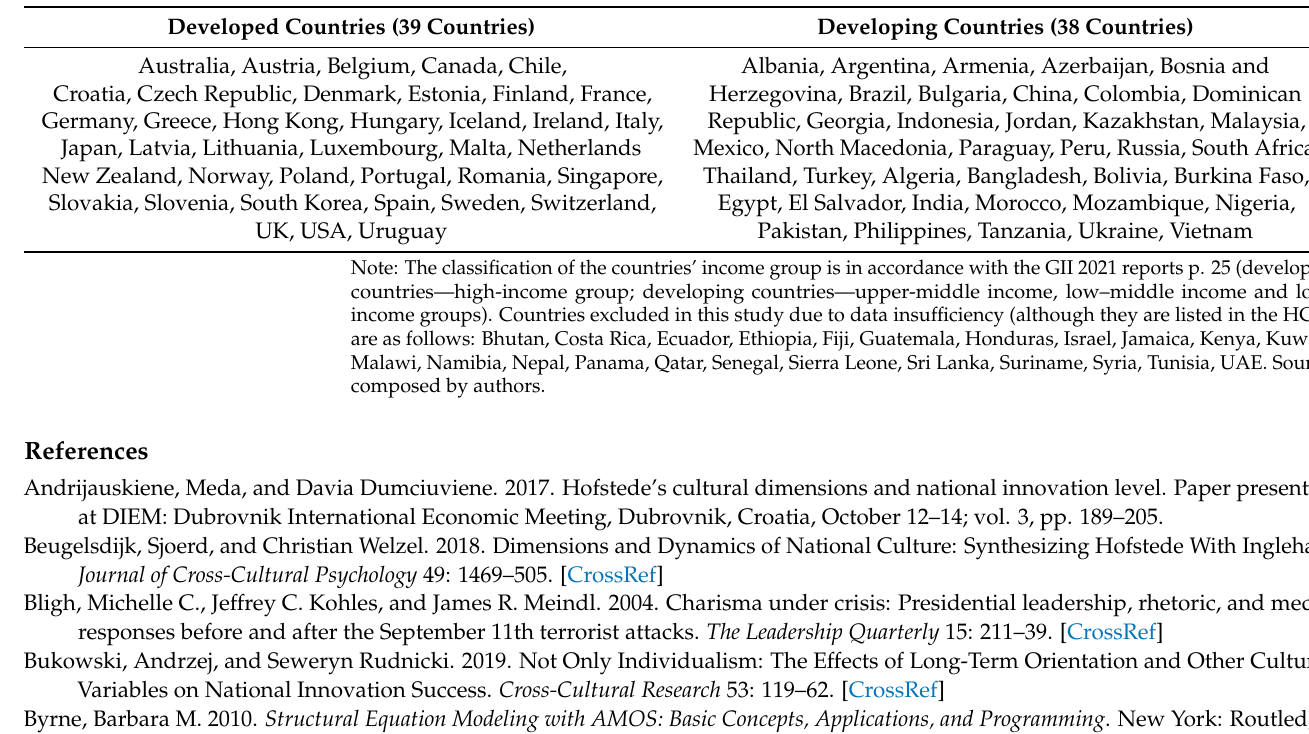
Table A2. Countries included in this